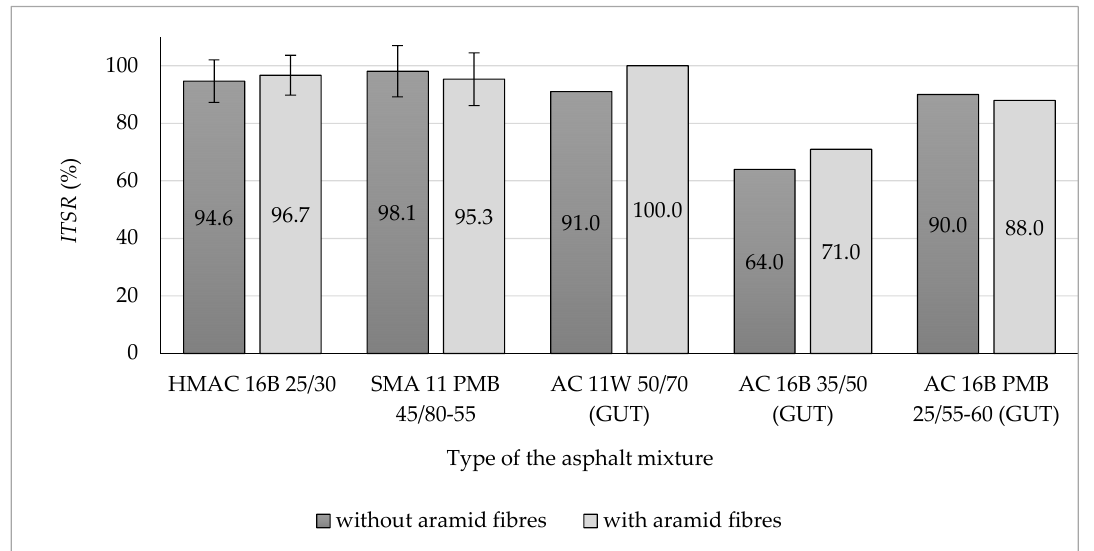
Figure 6. Proportional rut depth— PRD AIR after 10,000 load cycles of analysed asphalt mixtures (including HMA examined at the Gdańsk University of Technology [26]).